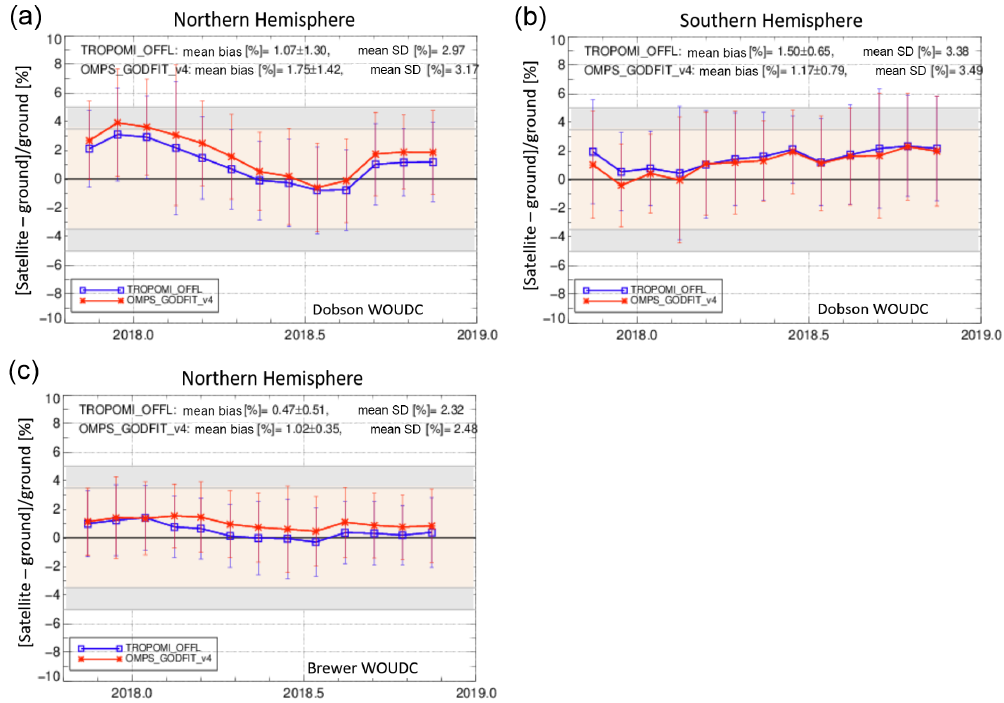
Figure 12. The time series of the percentage differences between TROPOMI OFFL and OMPS (processed with the GODFIT v4 algorithm) TOC versus Dobson ( a : NH; b : SH) and Brewer ( c : NH) GB measurements from WOUDC. The blue line shows the TROPOMI OFFL TOC comparisons and the red line depicts the OMPS comparisons to co-located GB measurements. The time series of the three sensors refer to the same temporal range.